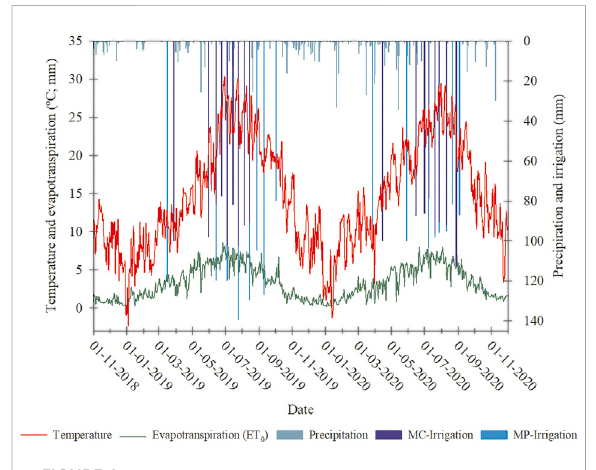
FIGURE 1 Daily mean air temperature (red continuous line), reference evapotranspiration (ET o ) (green continuous line), precipitation (green vertical bars), maize monoculture (MC) system irrigation (purple vertical bars) and pea-maize (MP) cropping system irrigation (blue vertical bars) and throughout the entire experimental